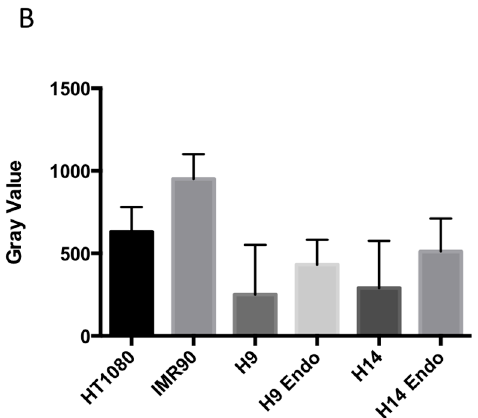
Figure 1. ( A ) Immunofluorescent microscopy staining of various cell lines for H3K9me3 ( green ) and DAPI ( blue ), intersecting regions show as cyan on the merged images; ( B ) Fluorescence intensity analysis of H3K9me3 staining in various cell lines. Scale bars are 10 µm.